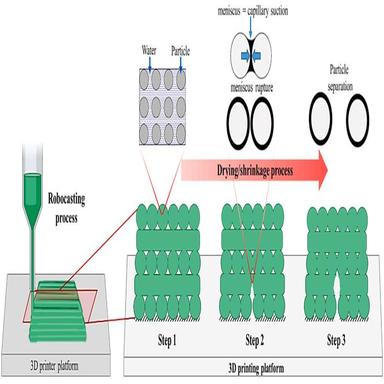
Scheme of the drying process after robocasting. Step 1) the base of the as-printed object is generally attached to the printing platform, each deposited filament (in green) is formed by particles surrounded by water. Step 2) water evaporation develops water meniscus between the particles that create capillary forces of suction, as the shrinkage of the sample is restricted the weakest meniscus breaks creating the cracks. Weaker meniscuses have low curvature and therefore are localized inside the object wher